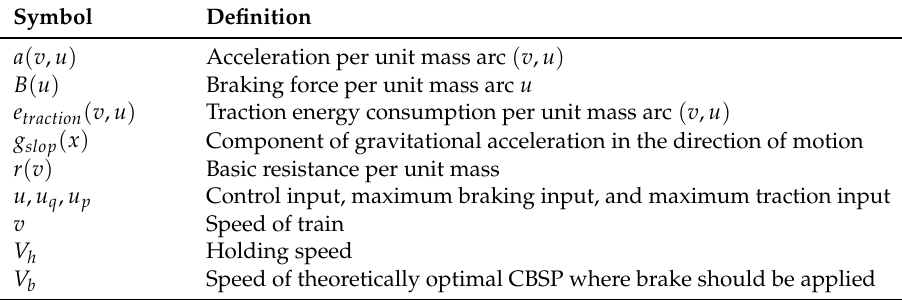
Table 1. Subscripts, parameters, and variables used in the mathematical